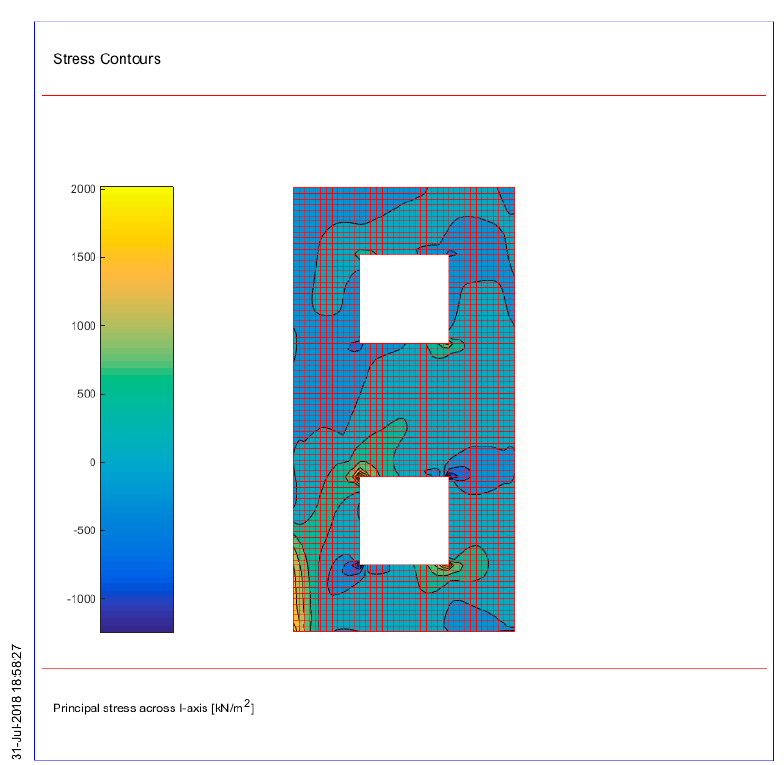
Figure 21. Stress contours of principal stress across I-axis (PGA = 0.40 g).